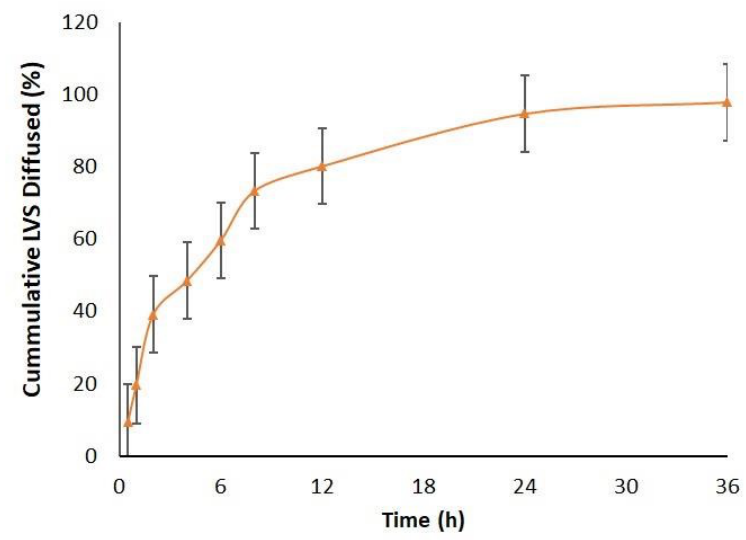
Figure 2. Time course of the cumulative di ff usion of LVS-ZN NPs in 0.1 mM phosphate bu ff er, pH 7.4, for 36 h (mean ± SD, n = 3).